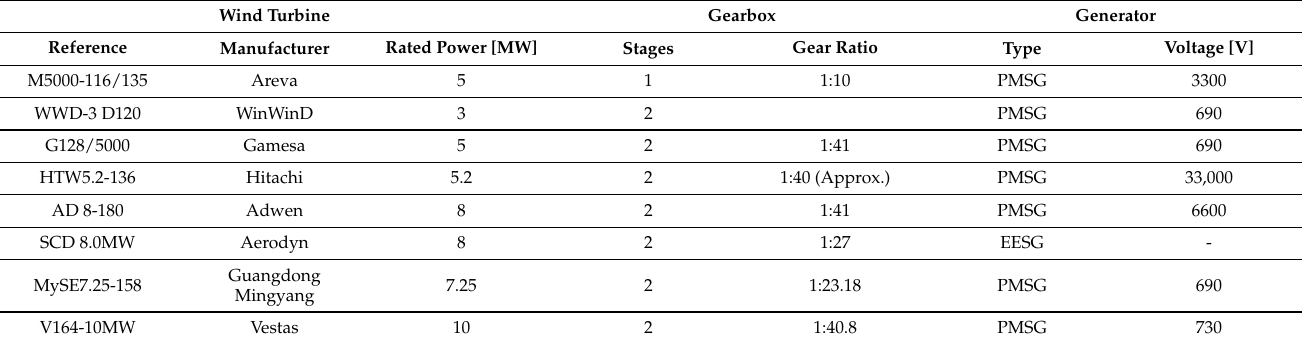
Table 7. Example of multi-megawatt variable speed with full-scale frequency converter wind turbine concept (PMSG/EESG system with one/two-stage